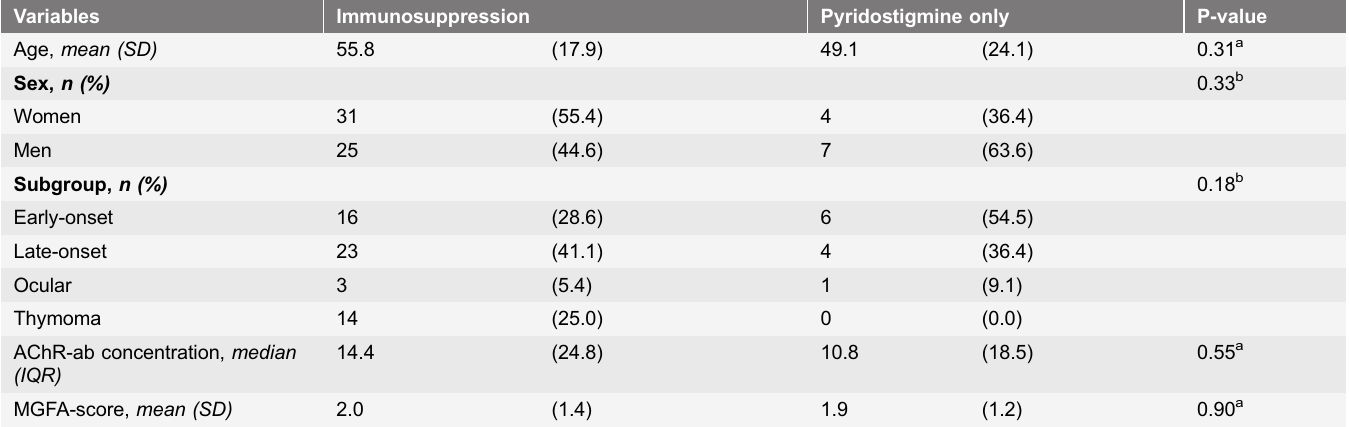
repeated measures within patients). The median AChR- antibody concentration was 14.4 for the immunosuppressed MG group, and 10.8 for pyridostigmine MG group. Inter-examiner agreement for MGFA was Kappa (K) 0.84 (almost perfect) percent of agreement was 88 percent. McNemar-Bowker’s test showed no disagreement symmetry (p 5 0.368). A high MGFA-score was more probable in the first quartile, and the score decreased significantly with increasing time since onset Table 3. Demographic statistics at first antibody test of all MG patients (n 5 67) with two or more positive AChR-antibody tests registered as living in western Norway 1983–2013 according to immunosuppressive (n 5 56) and pyridostigmine (n 5 11)